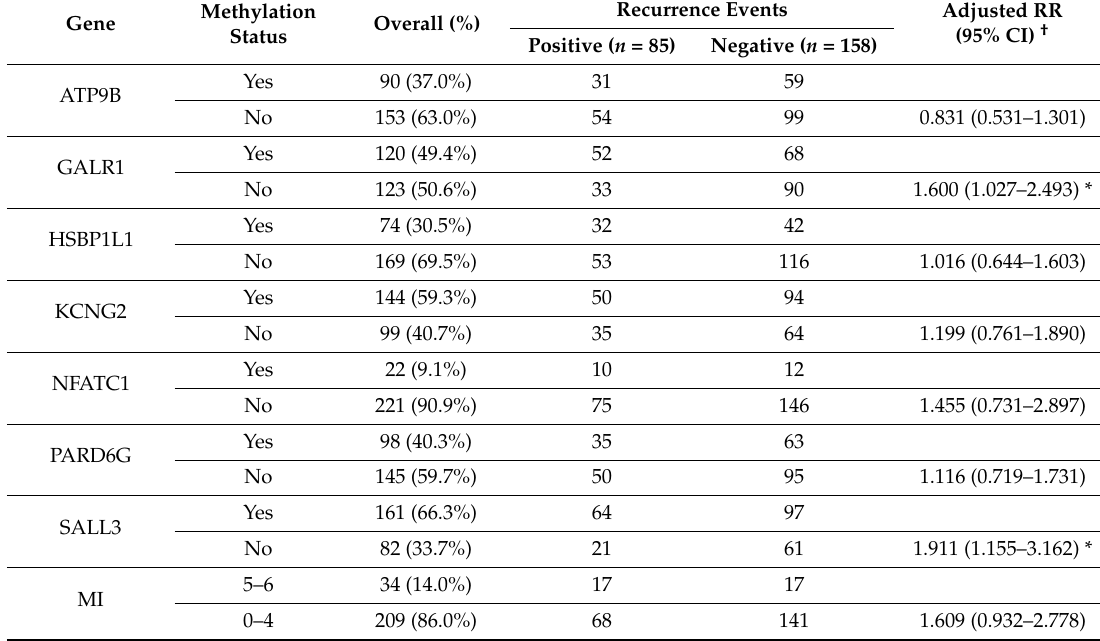
Table 3. Methylation status of individual genes and associations with disease-free survival using Cox proportional hazards model in 243 patients.